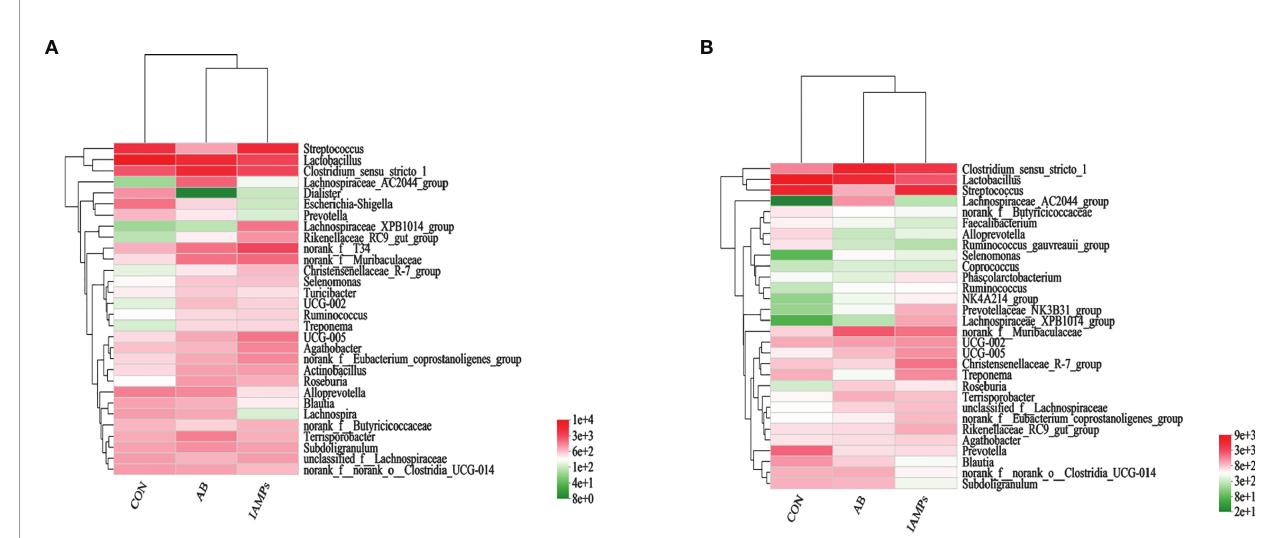
FIGURE 6 | Heatmap of microbial community representing the top 30 bacteria at the genus level. (A) Cecum; (B) colon.The individual pig was regarded as the experimental unit (n = 5). CON, corn – soybean meal-based diet; AB, CON + 25 mg/kg fl avomycin + 50 mg/kg quinocetone; IAMPs, CON + 1,000 mg/kg